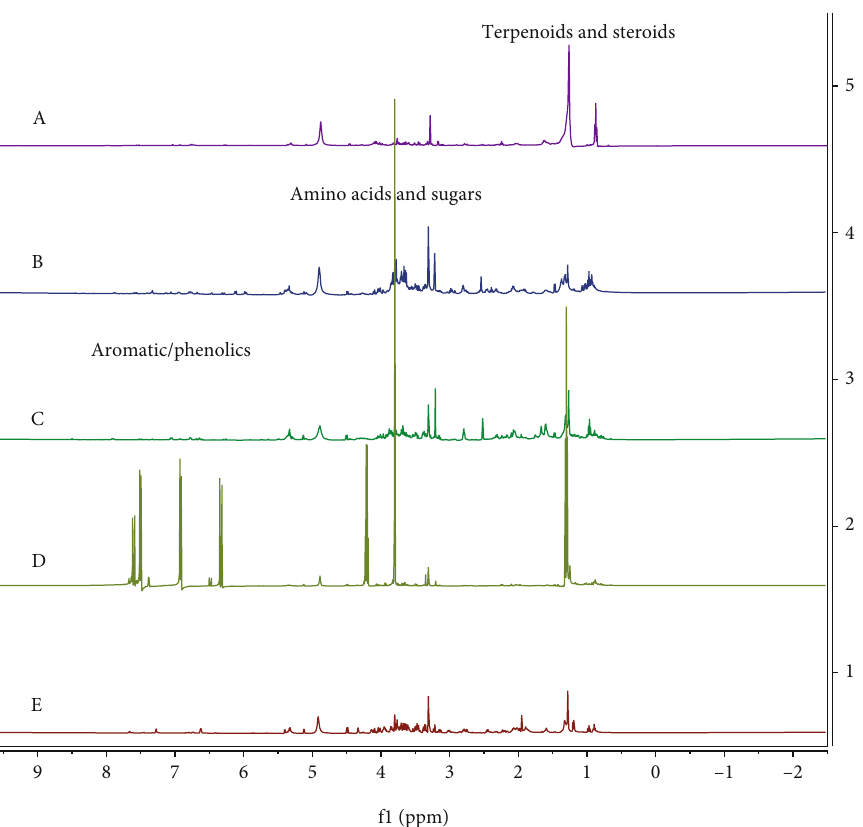
Figure 2: 1 H-NMR pro fi le of E. elatior (a), A. graveolens (b), O. xcitriodorum (c), K. galanga (d), and P. amaryllifolius (e)